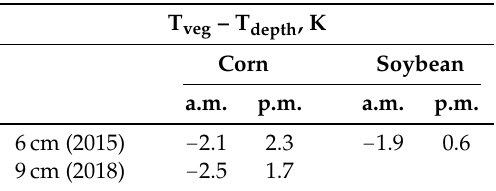
Table 3. Difference between vegetation canopy temperature, T veg , and soil temperature, T depth , in corn and soybean, where T depth is 6cm in 2015 and 9cm in 2018 as illustrated in Figure 3. Data is limited to SMAP overpass times in